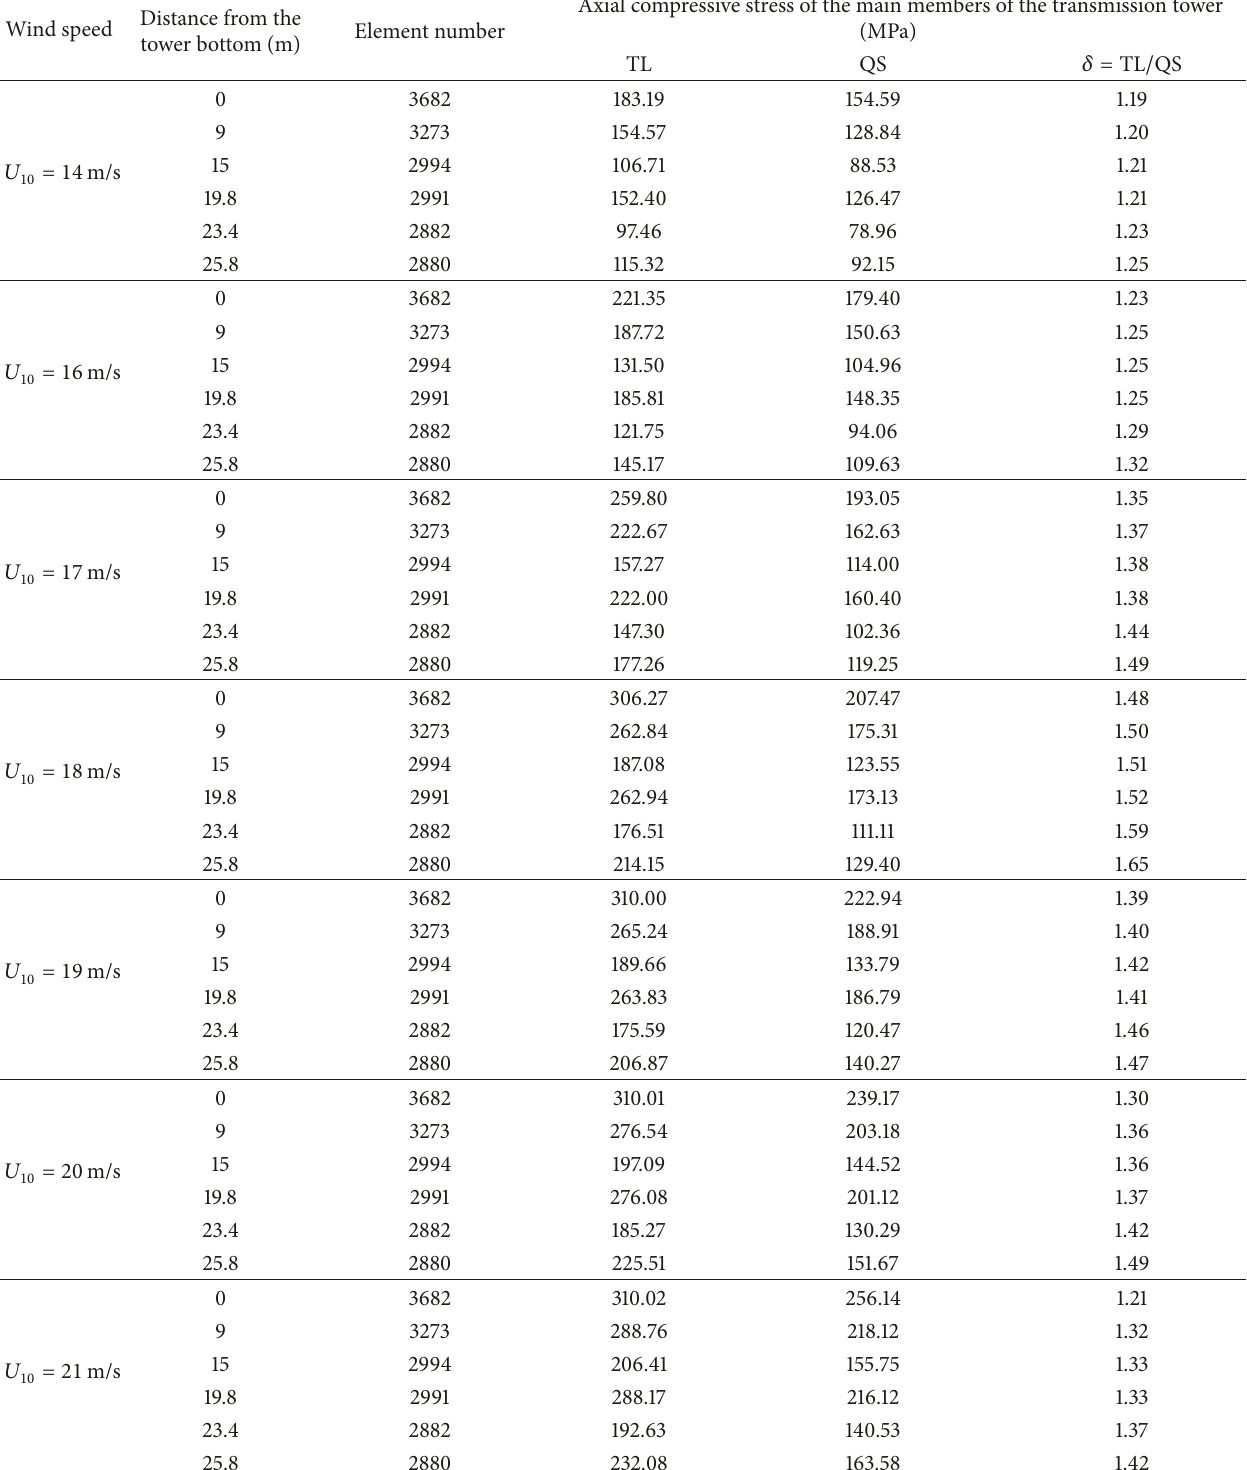
Table 12: Comparison of the stress at the top of the tower calculated by dynamic analysis in the tower-line system and by the quasi-static calculation for the corresponding single